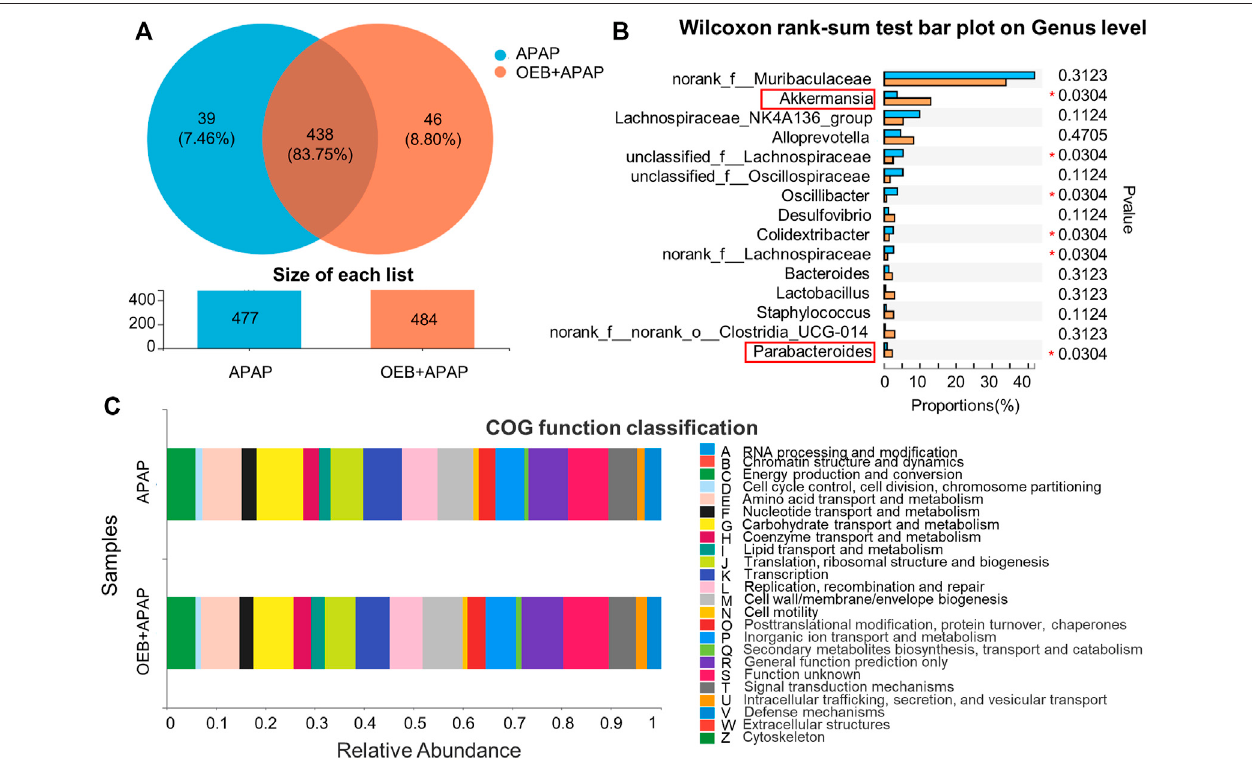
FIGURE 7 | 16s-Seq analyses revealed signi fi cant difference in gut microbiota between the presence and absence of OEB pretreatment in the APAP treated groups. (A) Venn diagram showing the number of speci fi c commensal gut microbiomes and the overlap between APAP ( n = 4) and OEB + APAP ( n = 4) groups. (B) Wilcoxon rank-sum test bar plot revealed differentially enriched microbiota between APAP ( n = 4) and OEB + APAP ( n = 4) groups on genus level. (C) COG function classi fi cationanalysisrevealeddifferentiallyenriched bacterialfunctionsassociatedbetweenAPAP( n =4)andOEB+APAP( n =4)groups.* p < 0.05versusAPAP- treated